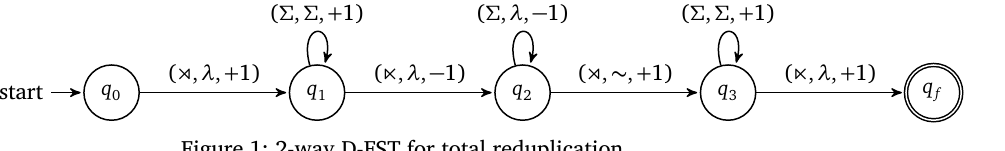
The transition arcs are interpreted as follows. The symbol Σ is a variable representation of any alphabet symbol except for f ⋊ , ⋉ g .